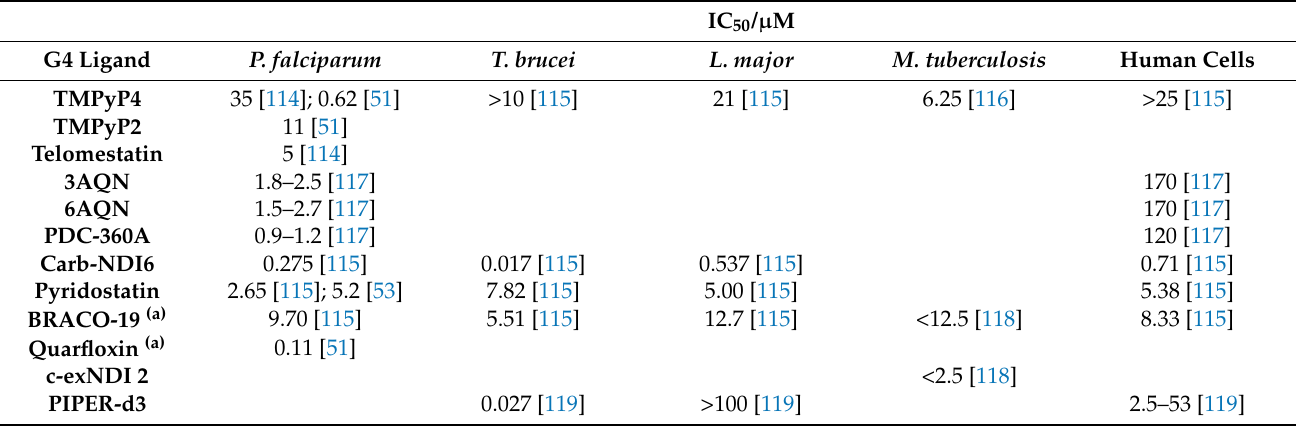
Table 2. Antiparasitic and antibacterial activity of G4 ligands. Structures are depicted in Figure 6. IC 50 / µ